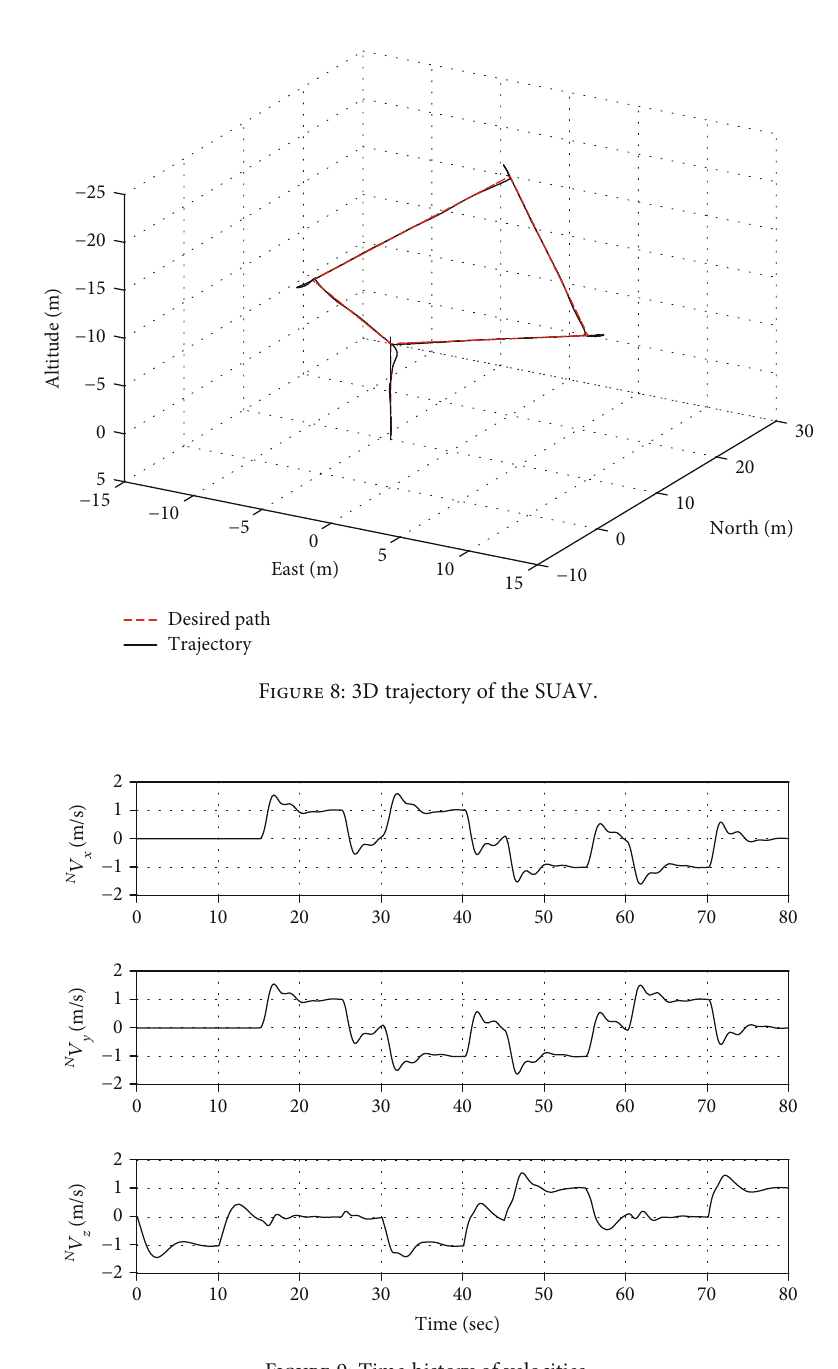
Figure 9: Time history of